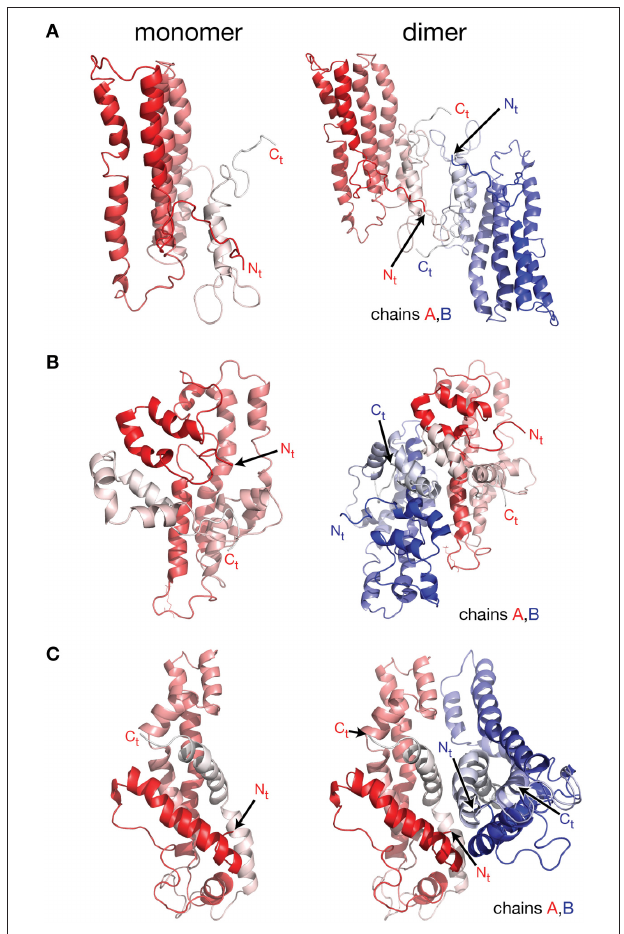
FIGURE 2 | Molecular models of lipid free apoA-I. Models of lipid free apoA-I monomer in solution were proposed over the last decade by Silva et al. (2005a), Pollard et al. (2013), and Segrest et al. (2014). (A) Left: cartoon representation of the lipid free apoA-I monomer model proposed by Silva et al. (2005a). The protein chain is colored with gradient red (N t is colored with solid color and C t with faded color). Right: cartoon representation of a model of a lipid free apoA-I dimer constructed here by positioning two Silva et al. apoA-I monomer models next to each other such that the C t domains of the two apoA-I chains mutually interact. Most of the reported crosslinks, detected by MS, are between 15 and 35 Å and located at the interaction interface between the two monomers in this model of the dimer. (B) Left: cartoon representation of the lipid free apoA-I monomer model proposed by Pollard et al. (2013). Right: cartoon representation of a model of lipid free apoA-I dimer built here from two Pollard et al. apoA-I monomer models. The C t domains of the two apoA-I monomers mutually interact and are oriented perpendicular to each other. The K 88 –K 118 crosslink detected by MS for the apoA-I dimer is about 10 Å in this dimer model. (C) Left: cartoon representation of the lipid free apoA-I monomer model proposed by Segrest et al. (2014). Right: cartoon representation of a model of a lipid free apoA-I dimer constructed here by positioning two Segrest et al. apoA-I monomer models next to each other such that the C t domains of the two apoA-I chains are oriented antiparallel and mutually interact. The K 88 –K 118 crosslink for apoA-I dimer reported by Pollard et al. (2013) is 58 Å in the dimer